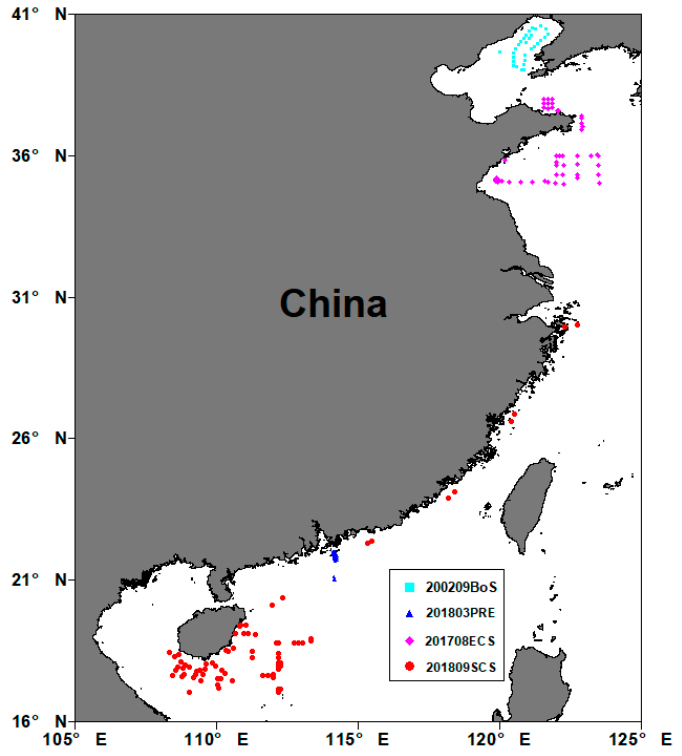
Figure 1. Stations of the China Sea used in the study. Table 2. Location, period, number, and source of R rs samples used in the